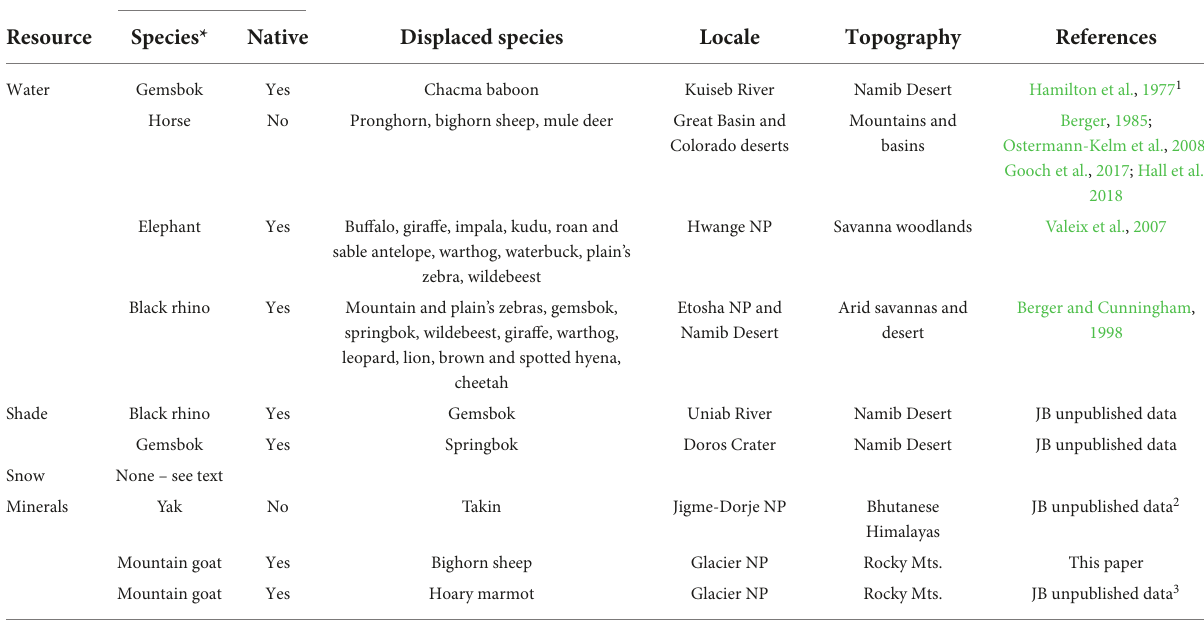
TABLE 1 Examples of interspecies conflict, displacement in five mammalian orders (Artiodactlya, Perissodactyla, Carnivora, Rodentia, and Primates) over access to water and minerals with notation on potential for contests for additional products (shade, snow) including (feral) horses and (domestic) yaks as exotic